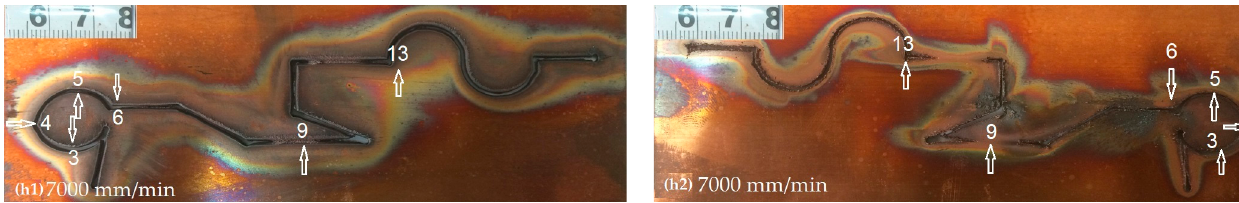
Figure 8. The cutting path width of ( h1 , h2 ) at 7000 mm/min at 30 A for Points 3, 4, 5, and 6.